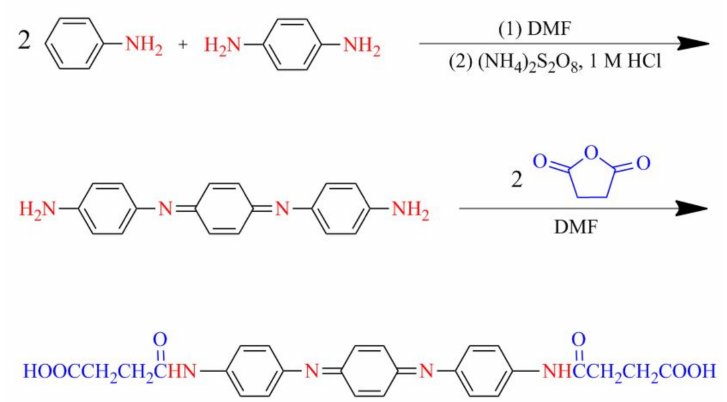
Figure 13. Chemical synthesis pathway of carboxyl-capped aniline trimer.